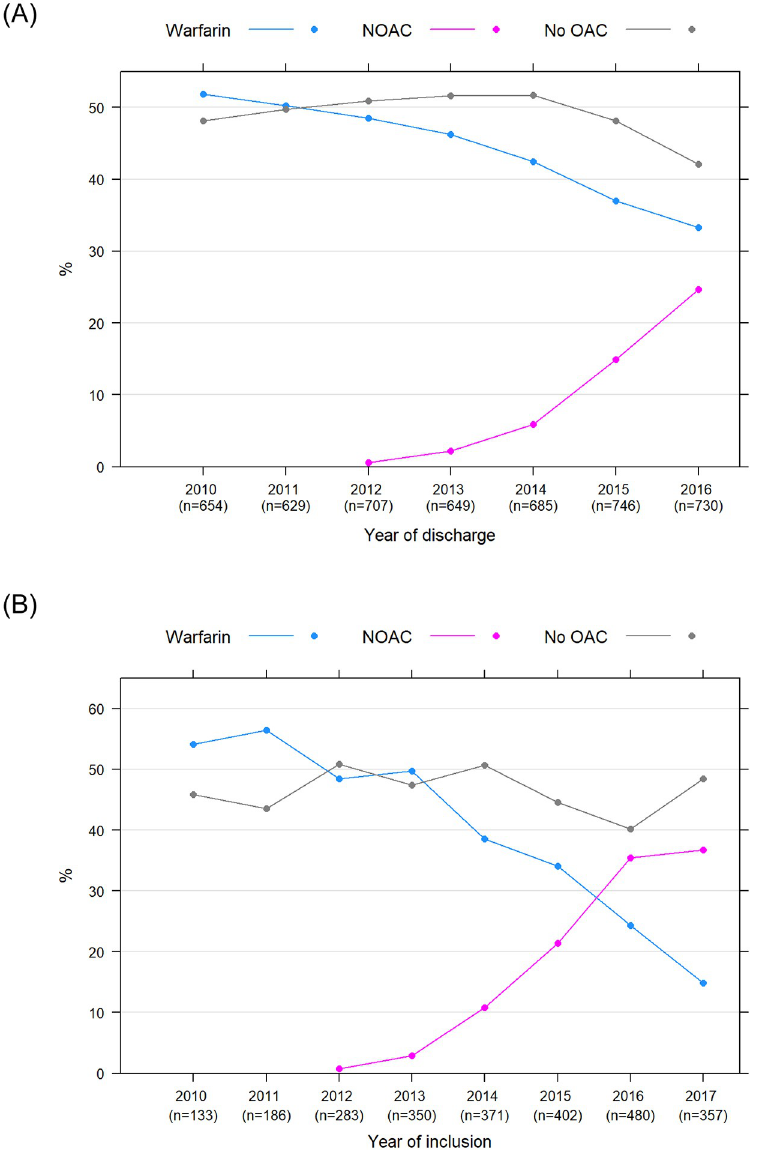
Fig 3. The proportion of patients with atrial fibrillation and dispensation of oral anticoagulant treatment. The proportion of patients with history of atrial fibrillation and dispensation of oral anticoagulant treatment (A) at discharge from valve intervention. The proportion of patients with new-onset atrial fibrillation and dispensation of oral anticoagulant treatment (B) at start of the atrial fibrillation. Warfarin (blue line), NOAC (purple line) and no OAC (grey